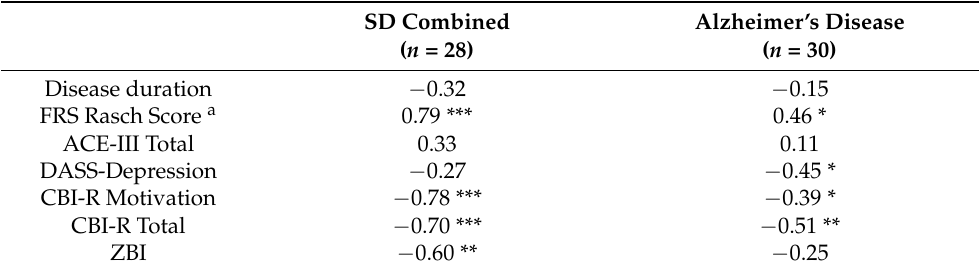
Table 2. Pearson’s r correlations exploring associations between carer-rated anhedonia severity on the SHAPS and clinical and behavioural measures in the patient groups. SD Combined Alzheimer’s Disease ( n = 28) ( n = 30) Disease duration − 0.32 − 0.15 FRS Rasch Score a 0.79 *** 0.46 * ACE-III Total 0.33 0.11 DASS-Depression − 0.27 − 0.45 * − 0.78 *** − 0.39